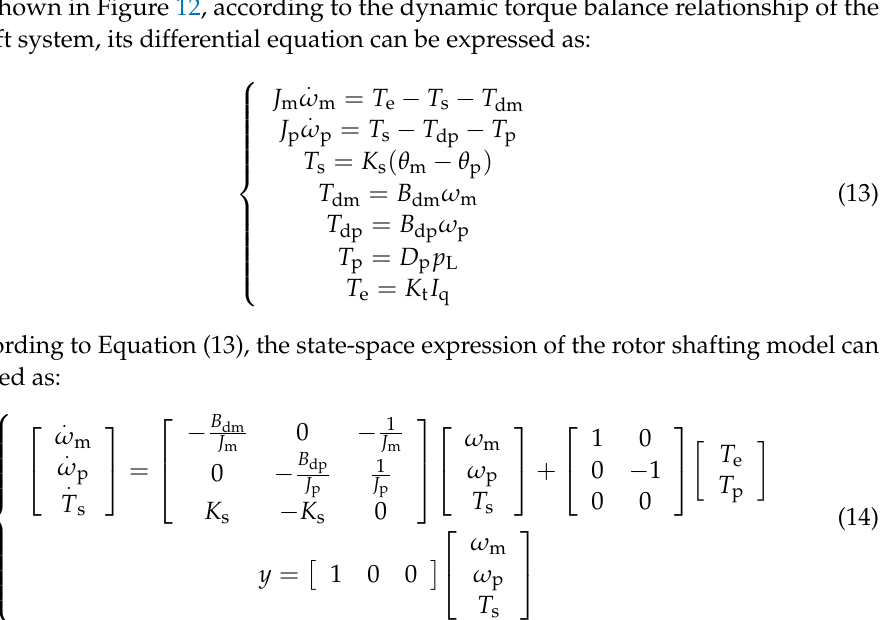
Figure 12. Structure diagram of the EPU rotor shaft system.